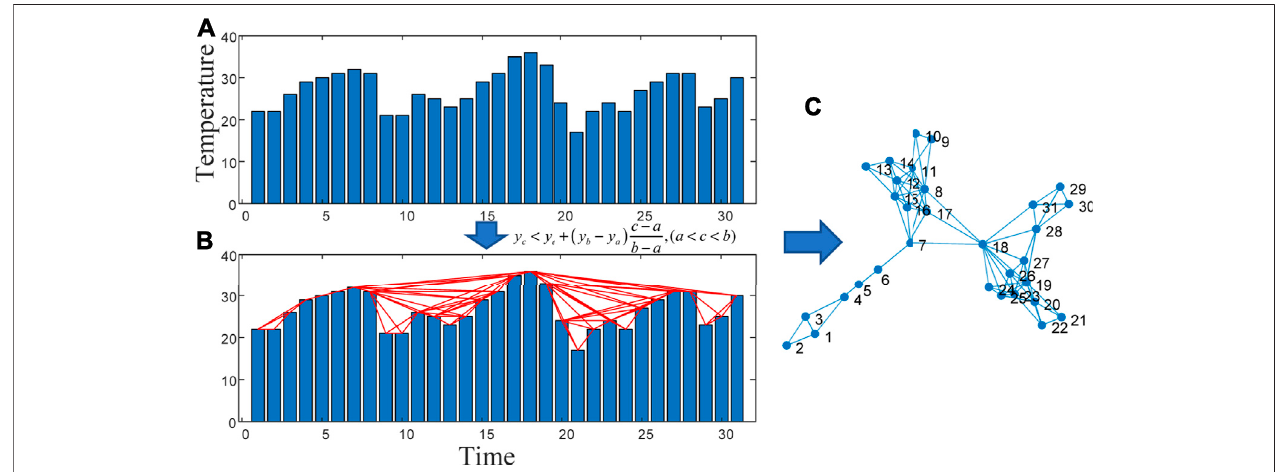
FIGURE 1 | Illustration of the network construction process from climate data through VG theory. In (A,B) , the abscissa is time (in days) and the ordinate is temperature (in ° C). Where (A) is the original data, (B) is the network generated by Eq. 4 , and (C) is the network structure presented as a